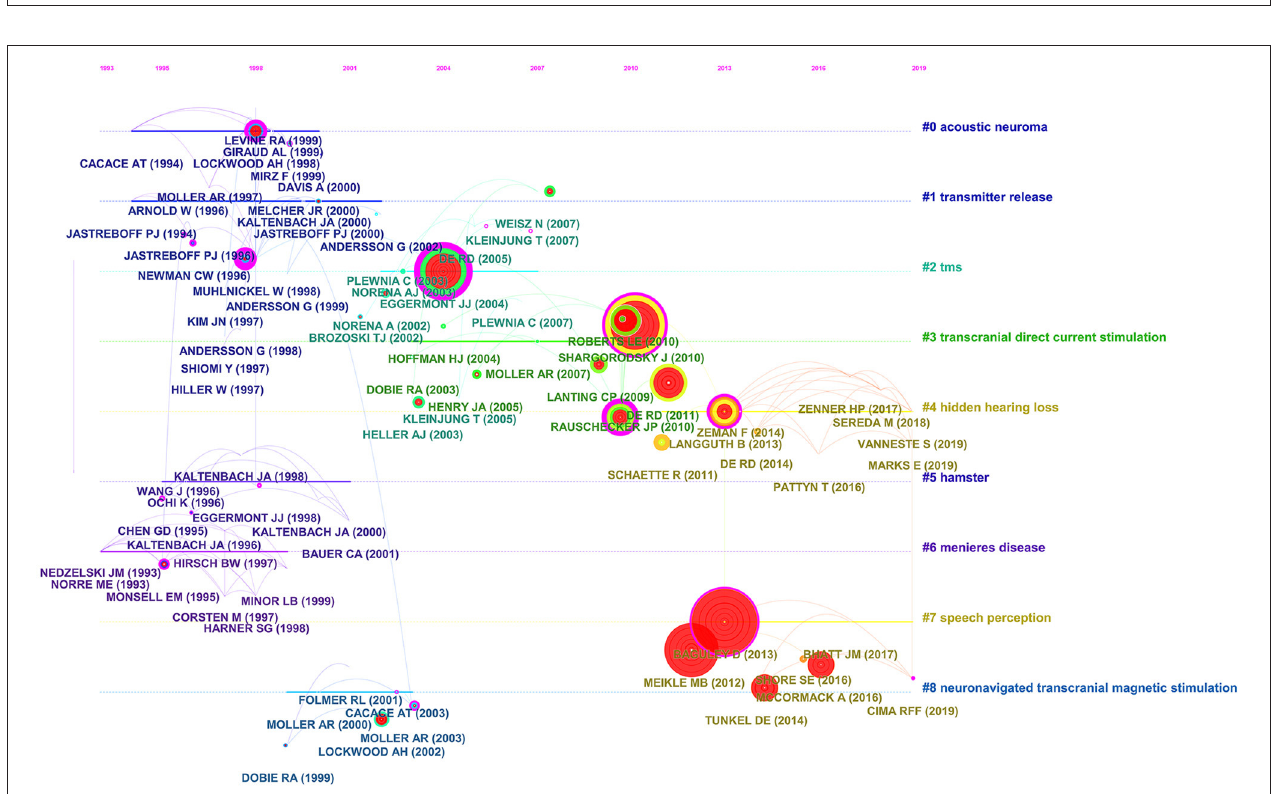
FIGURE 7 | The timeline view of co-cited clusters with cluster labels. This view clearly presents the differences in the appearance time point and time span of nine clusters.